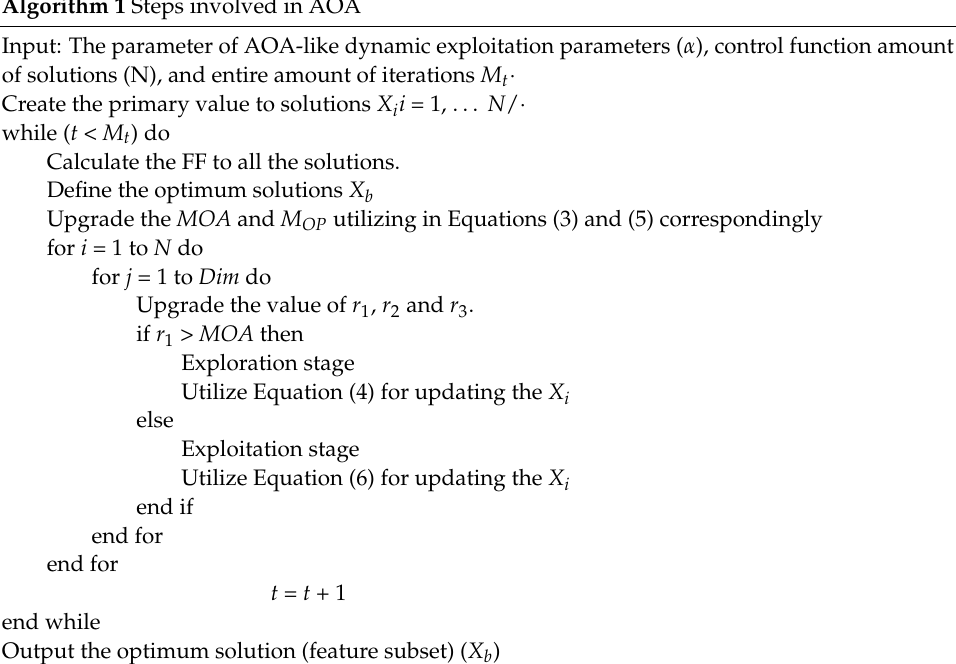
Algorithm 1 Steps involved in